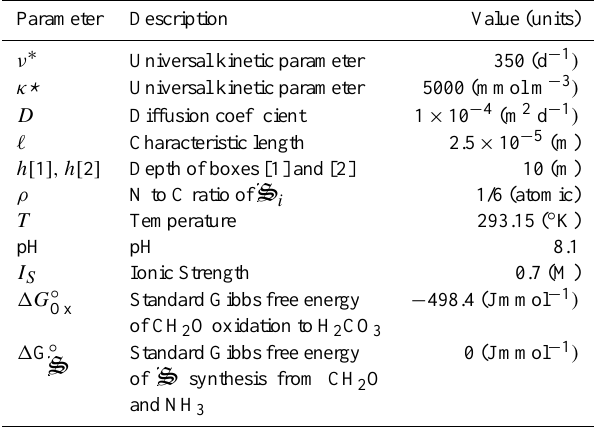
Table 1. Model fixed parameter